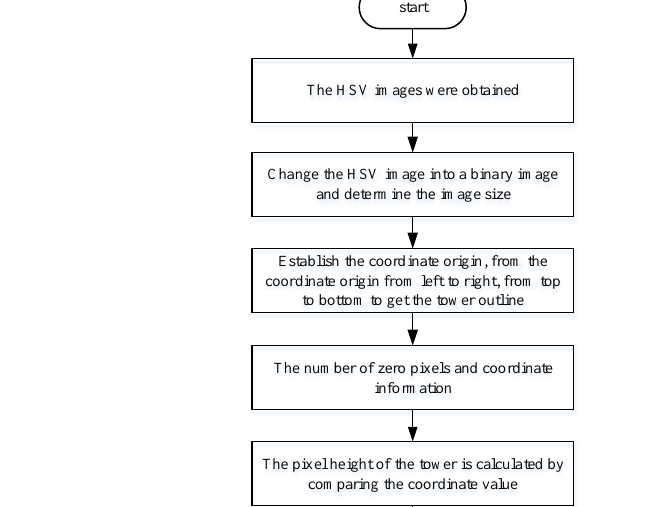
Figure 9. Pole and tower pixel coordinate traversal process.